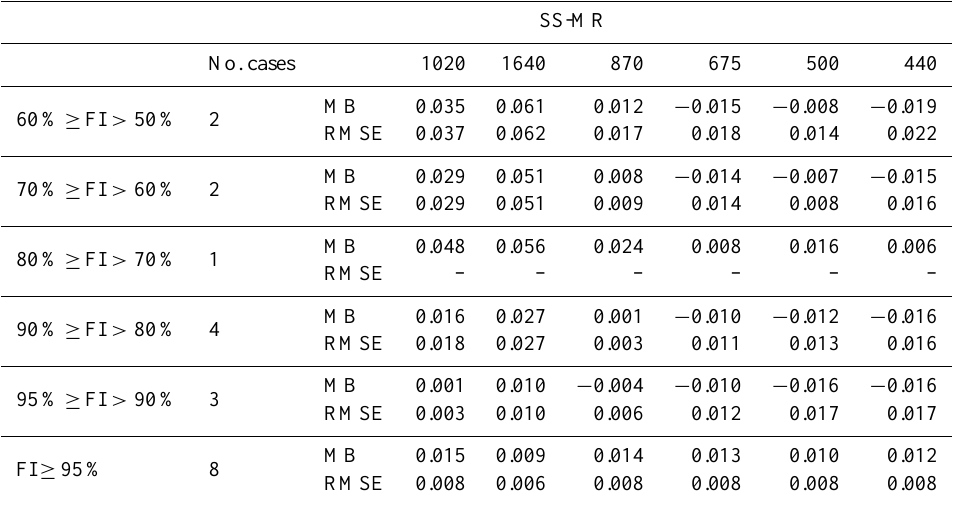
Table 6. MB and RMSE values for AOD differences between CE318-AERONET daytime and CE318-T night-time data during sunset- moonrise (SS-MR, defined as the last 1h of daytime data vs. the first 1h of nocturnal data) as a function of the average moon’s fraction of illumination (FI).